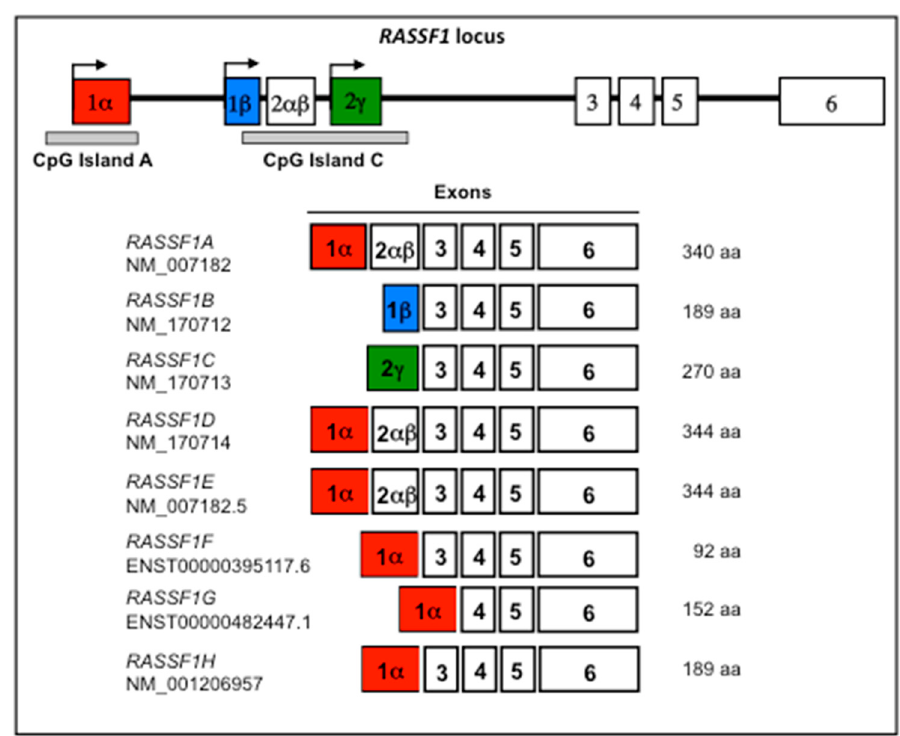
Figure 1. Schematic representation of the RASSF1 locus and its transcription map. White boxes represent the exons and the bold line represents the introns. RASSF1A (red), RASSF1B (blue), and RASSF1C (green) variants are generated by di ff erential promoter and first exon usage (arrows). RASSF1D , RASSF1E , RASSF1F , RASSF1G , and RASSF1H are variants derived from alternative splicing of RASSF1A . Two CpG islands (grey bands below exons 1 and 2) are associated to RASSF1 promoter region: CpG island A (736 bp, 85 CpGs, chr3:50,340,373-50,341,109, GRCh38 / hg38) extending in the promoter region of RASSF1A; CpG island C (1364 bp, 139 CpGs, chr3:50,336,834-50,338,198, GRCh38 / hg38) in the regulatory region of RASSF1B and RASSF1C . A CpG island is defined as a sequence with a length greater than 200 bp, a GC content greater than 50% and a ratio greater than 0.6 of the observed number of CG dinucleotides with respect to the expected number on the basis of the number of Gs and Cs nucleotides in the segment.